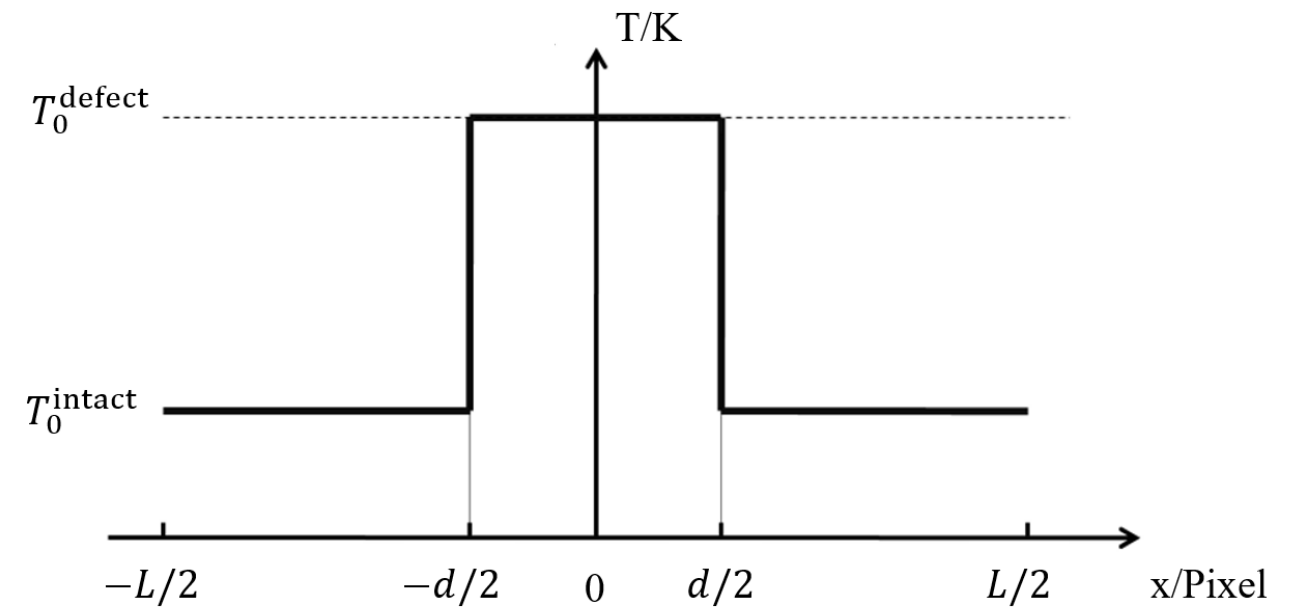
Figure 9. Temperature distribution on the surface of ceramic coating at the moment just turning off the excitation source.